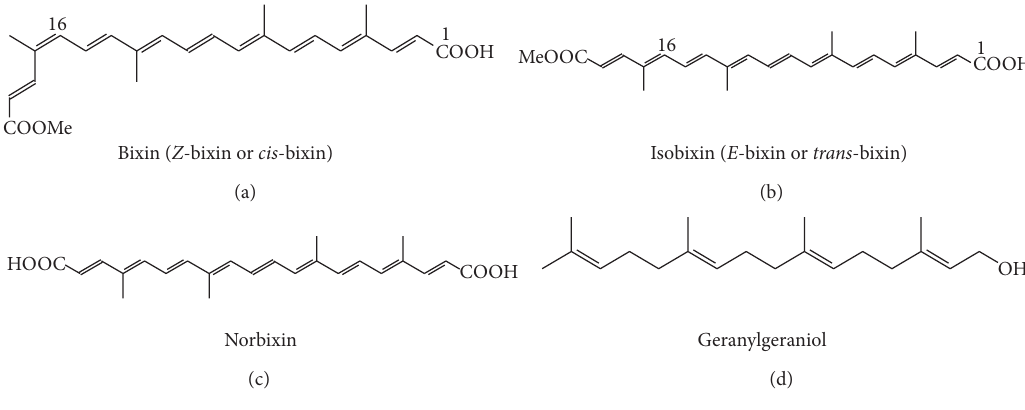
Figure 1: Chemical structure of some pigments of